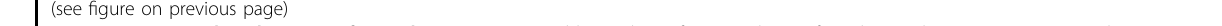
Fig. 2 P56S-VAPB alters late step of autophagy. a – c Immunoblot analysis of transiently transfected control GFP/RFP, wt-VAPB and P56S-VAPB; in NSC-34 cells ( a ), NIH3T3-GFP-LC3 fi broblasts ( b ) and of the Primary fi broblasts isolated from autophagy reporter GFP-LC3 transgenic mice (MEF-GFP- LC3) ( c ), and then additionally treated with the autophagy inhibitor Ba fi lomycin A (2 µM) for 2 h to inhibit autophagy followed by treatment